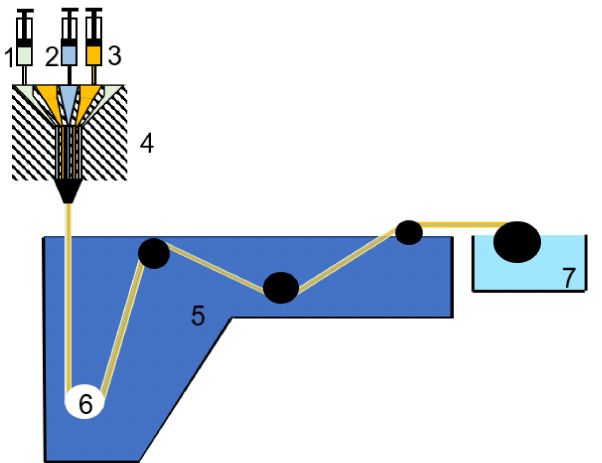
Figure 3. Dual-layer hollow fiber spinning by dry-jet/wet-quench set-up: ( 1 ) outer dope fluid, syringe pump and outer channel; ( 2 ) bore fluid, syringe pump and bore channel; ( 3 ) inner dope fluid, syringe pump and inner channel; ( 4 ) dual-layer spinneret; ( 5 ) coagulation bath; ( 6 ) fiber guiding wheel; ( 7 ) fiber collecting